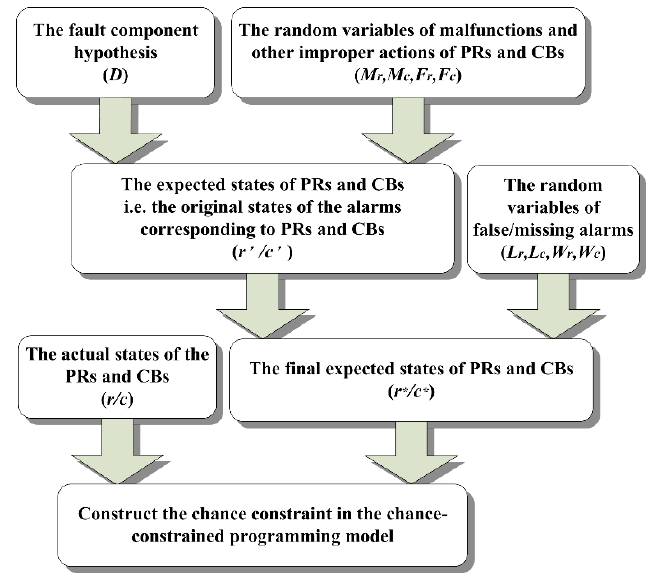
Figure 2. The flowchart of the establishment of the chance constraint.